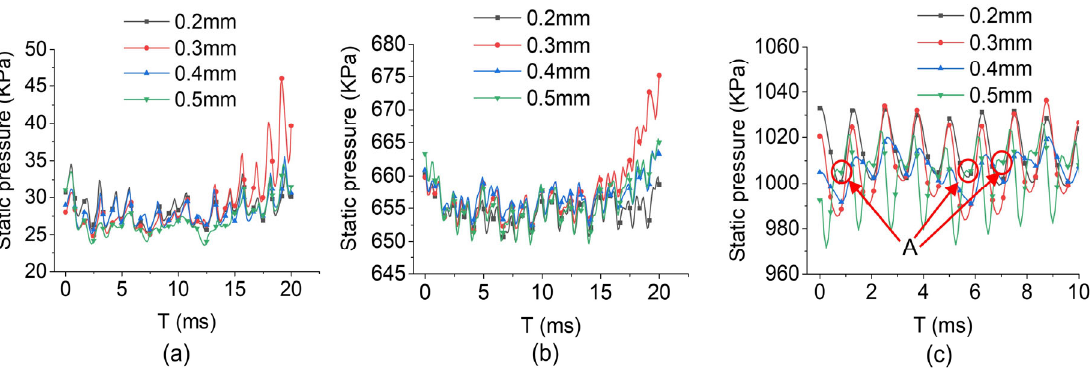
Figure 11. Pressure fluctuation diagram at key sections: ( a ) impeller inlet, ( b ) impeller outlet and ( c ) pump outlet.